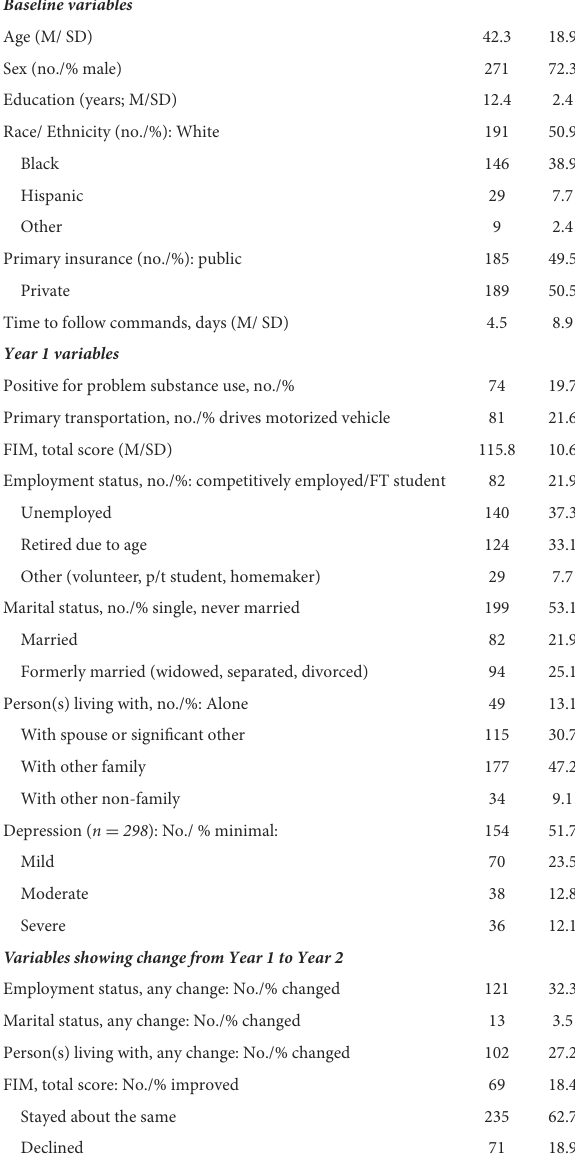
TABLE 1 Participant characteristics ( N =